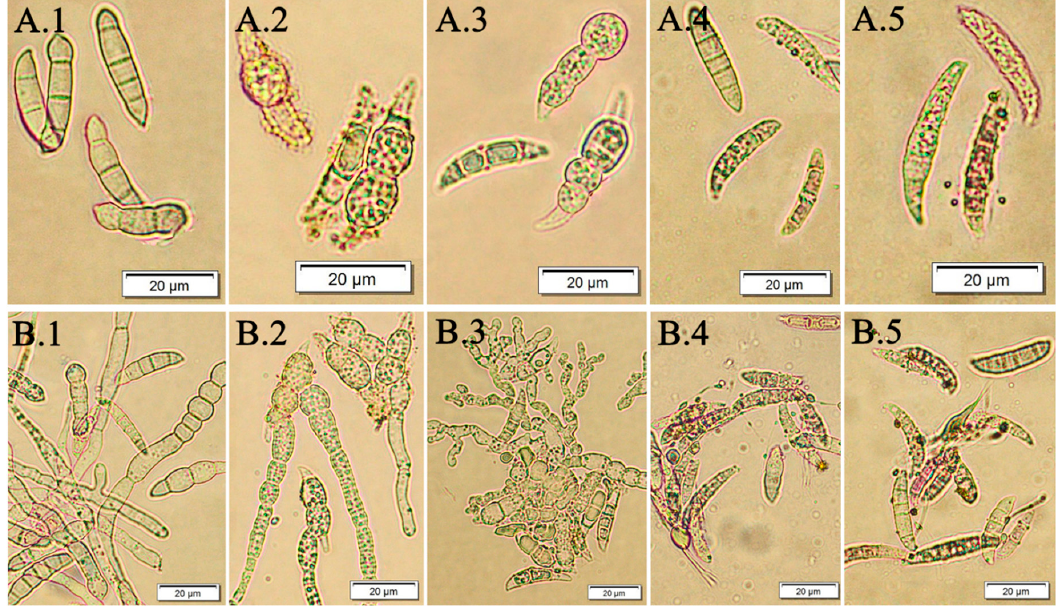
Figure 5. F. culmorum DEMFc37 treated with F. vesiculosus RB extract (RB.E) after 120 h incubation, ( A ) non-germinated; ( B ) germinated macroconidia with hyphae of different length; (1) RB control